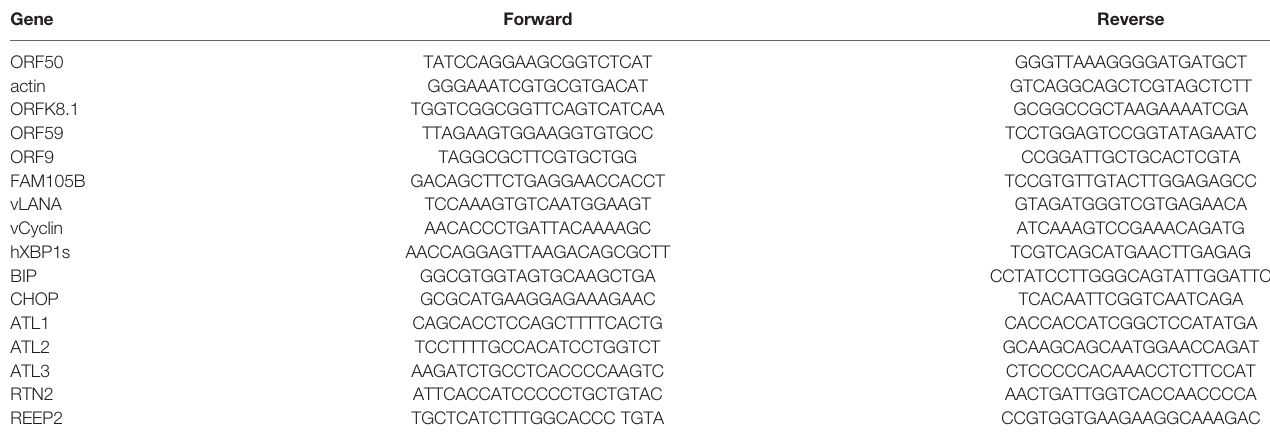
TABLE 1 | Oligonucleotides used for PCR and qRT-PCR analyses.